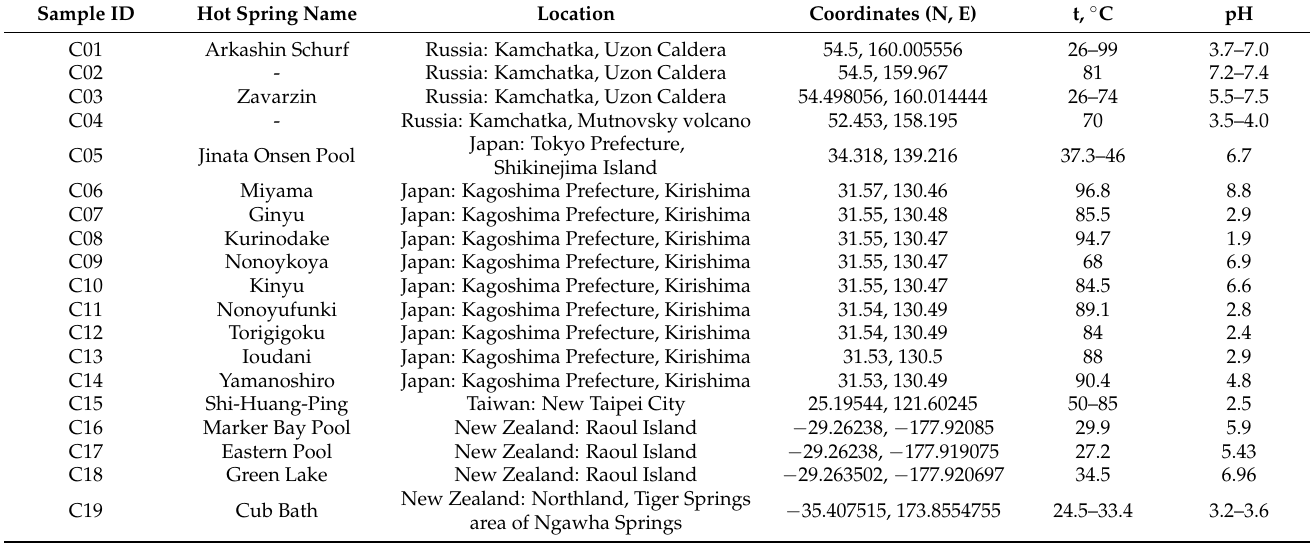
Table 1. Information about hot